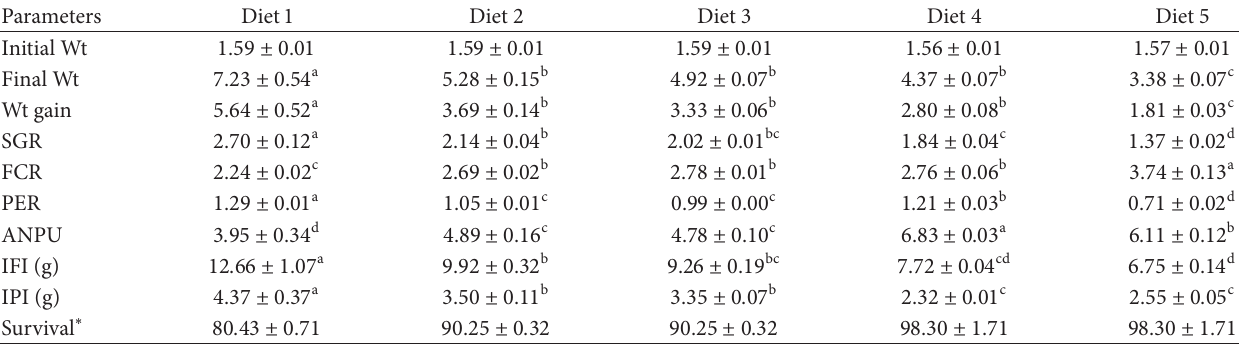
Table 5: Nutrient utilization of Clarias gariepinus fed dried brewer’s yeast meal substituted for soybean meal for 8 weeks.